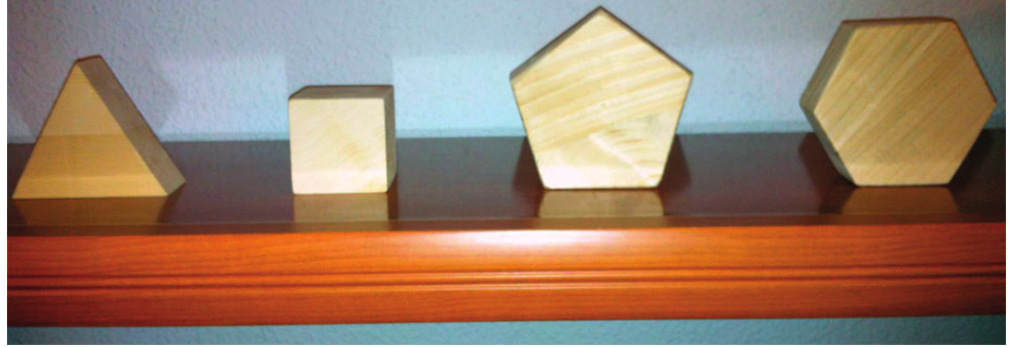
Figure 9. Some tangible objects used in Virtual Touch